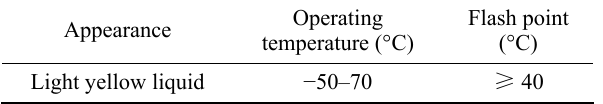
Table 3 Properties of the lubricating oil.